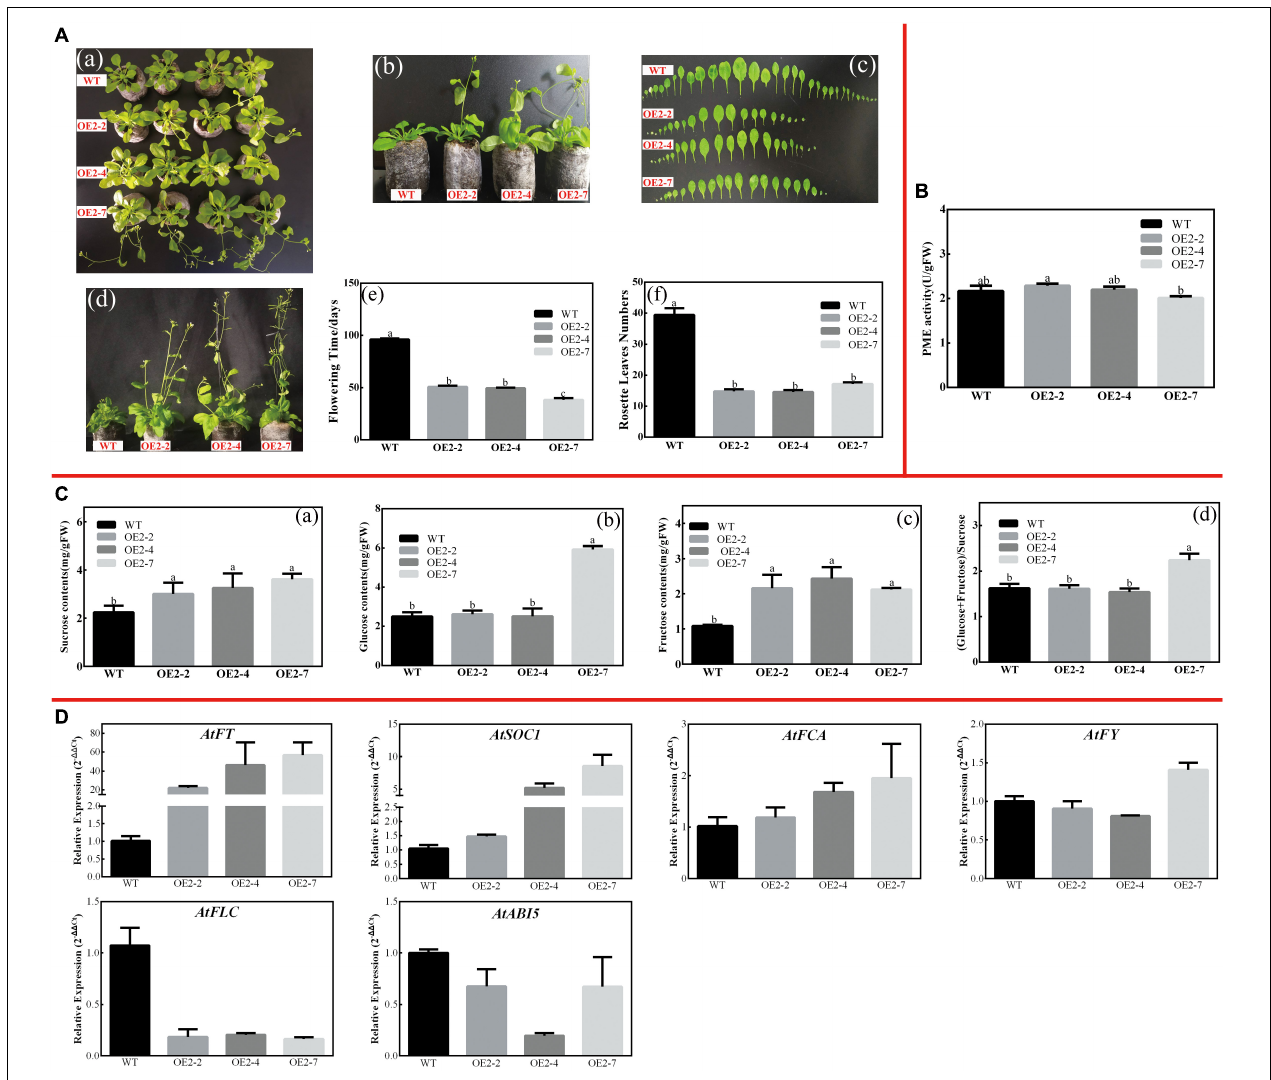
FIGURE 8 | Overexpression of CsPMEI2 promotes early flowering in transgenic Arabidopsis under SD condition. (A) Early flowering phenotypes of CsPMEI2 -OE lines grown under SD condition. (a) Early-flowering phenotype; (b) phenotypes of CsPMEI2 -OE lines and WT plants after 38 d of growth under SD condition; (c) leaf size; (d) phenotypes of CsPMEI2 -OE lines and WT plants after 96 days of growth under SD condition; (e) flowering time; (f) rosette leaves numbers. (B) PME activities of WT and CsPMEI2 -OE lines under SD condition. (C) Sugar contents of WT and CsPMEI2 -OE lines under SD condition. (a) Suc contents; (b) Glu contents; (c) Fru contents; (d) the ratio of hexose/Suc. (D) Expression analysis of flowering-related genes. The final results were calculated with 2 - (cid:49) (cid:49) Ct method. Data are shown as the means ± SE ( n =